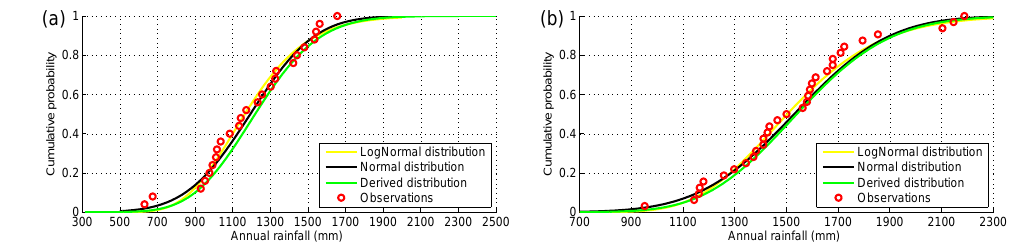
Figure 4. Cumulative distributions derived with the DD approach and fitted as a normal and lognormal distribution to annual precipitation totals for Concepción, Chile (a) and Lugano, Switzerland (b)